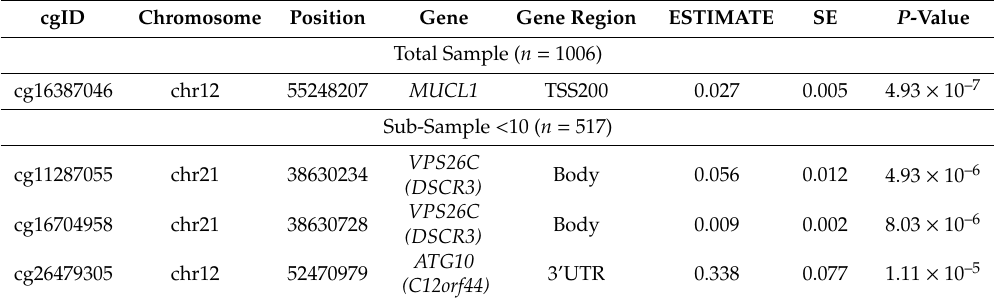
Table 4. Replication of CpGs from previous